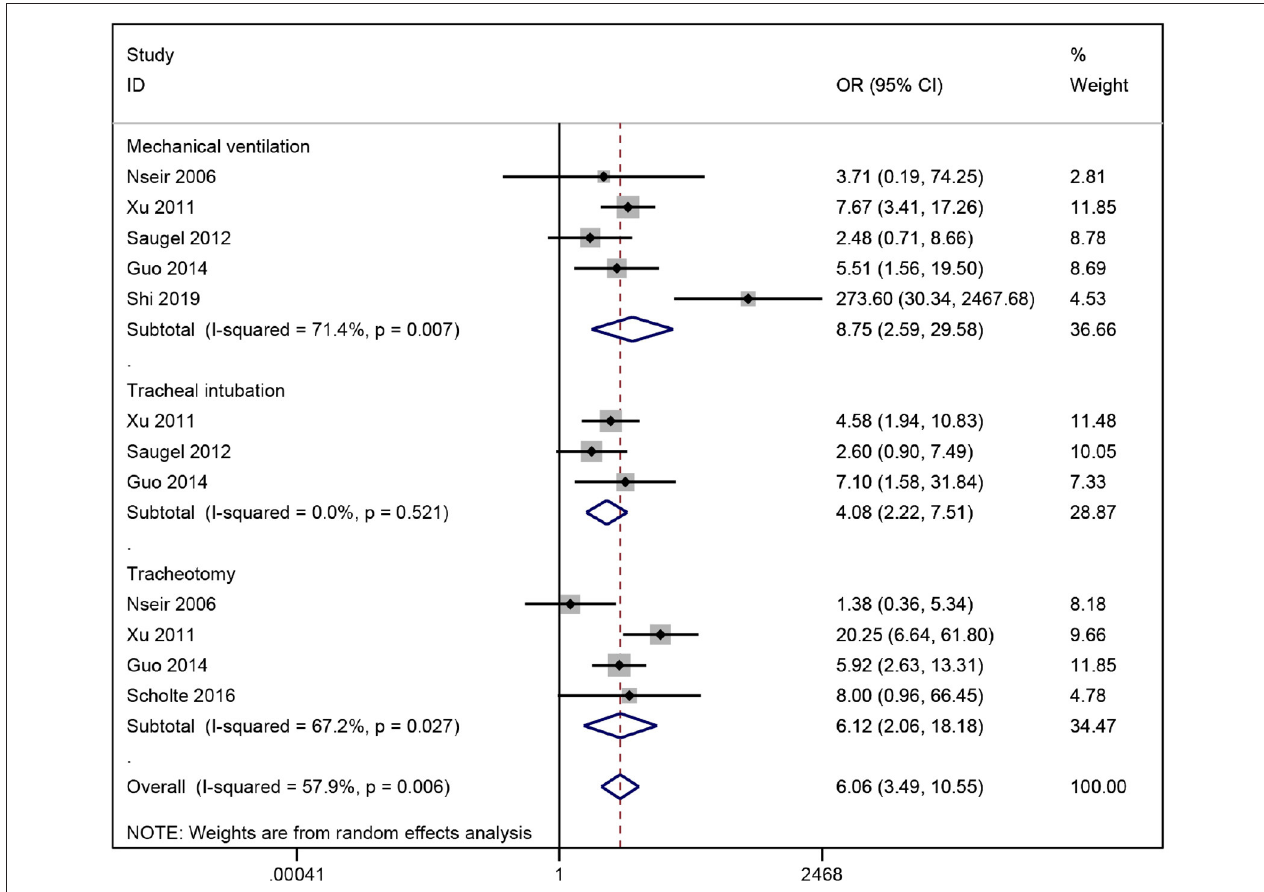
FIGURE 3 | Meta-analysis results of impact of invasive operations on risk factors for acquired Stenotrophomonas maltophilia in intensive care unit.